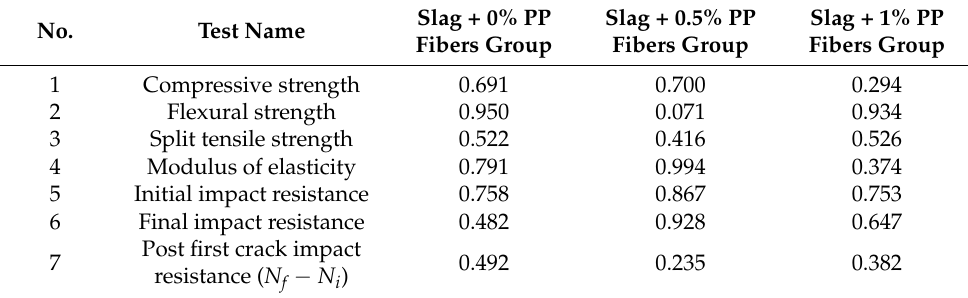
Table 9. p -values obtained through the Shapiro–Wilk method for the normality of